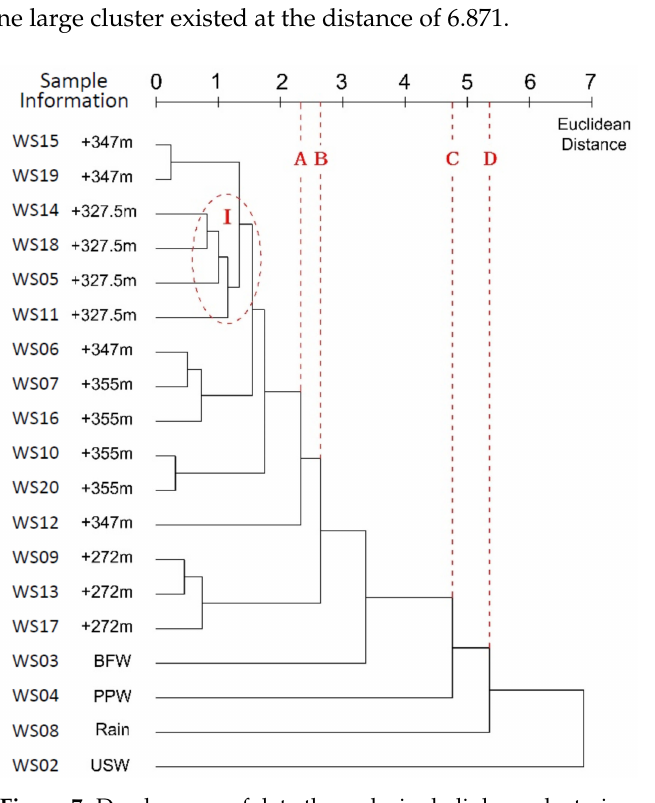
Figure 7. Dendrogram of data through single-linkage